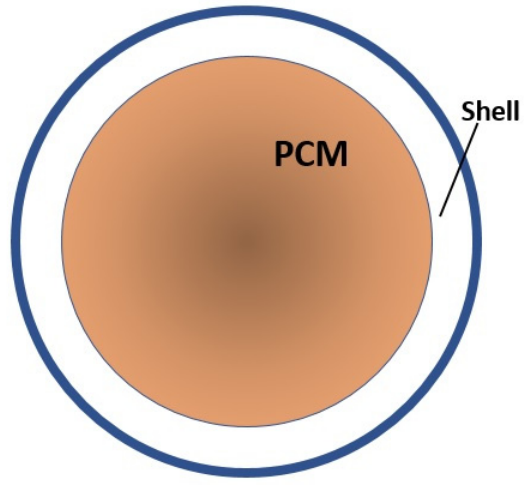
Figure 2. Microencapsulated PCM Diagram [22].